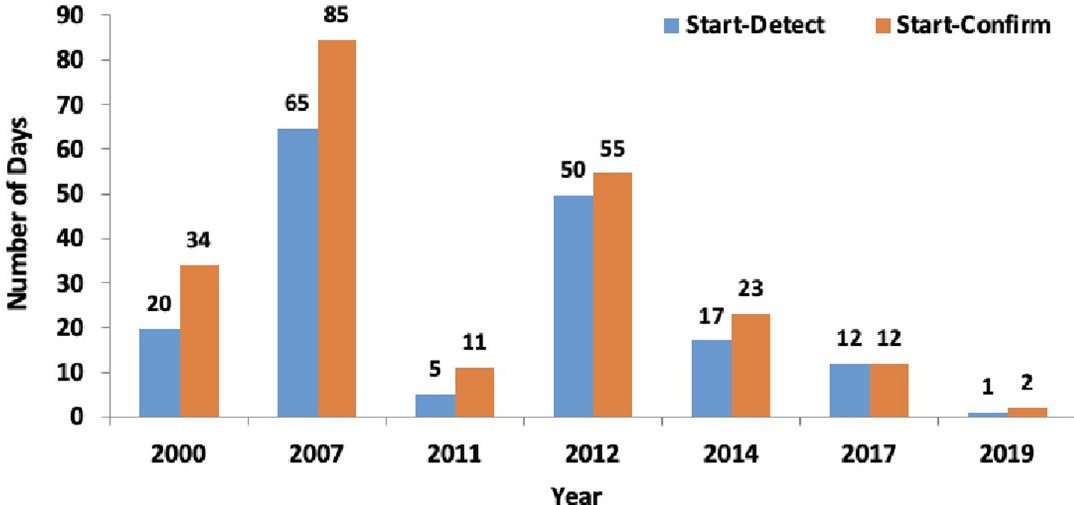
Fig 6. Number of days between the start, detection and confirmation of Ebola and Marburg outbreaks in Uganda, 2000–2020.